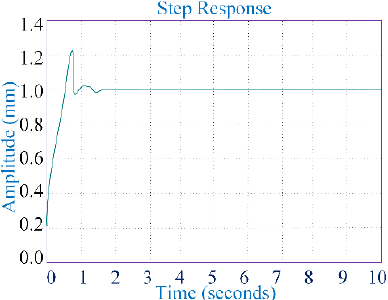
Figure 7. Step response curve of the classic PID control of the EHS system simulated by Simulink.